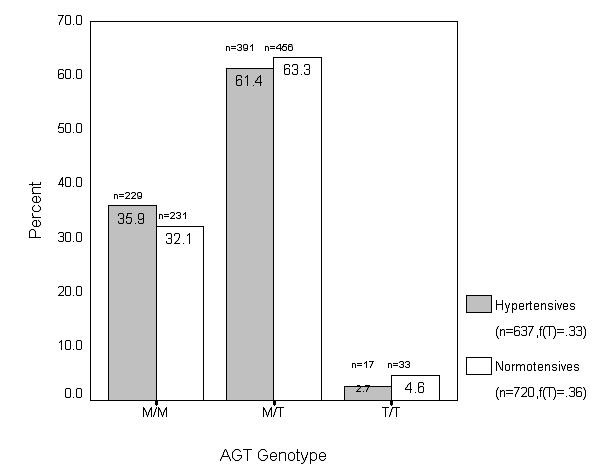
AGT genotypes and allele frequencies, both genders combined. No significant differences. F(T): frequency of T- allele.